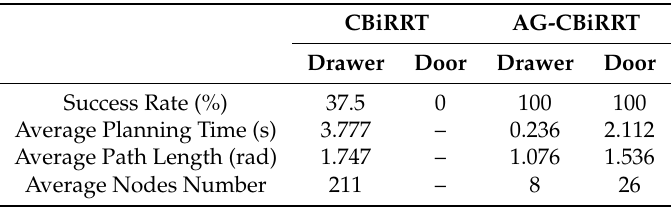
Table 4. Robot performing constrained manipulation on passive